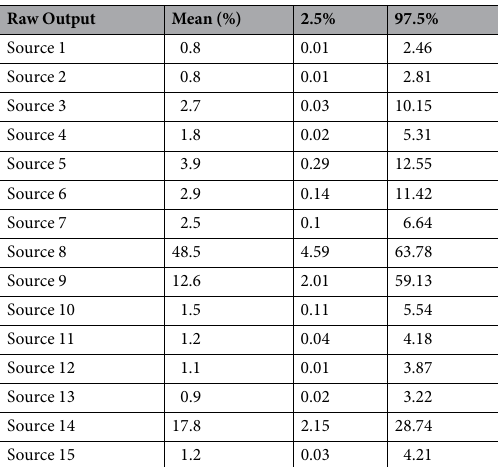
Table 3. Model outputs from theoretical example 2, displaying the raw MixSIAR output. Mean values (in %) are displayed alongside the 95% credible intervals for each model.